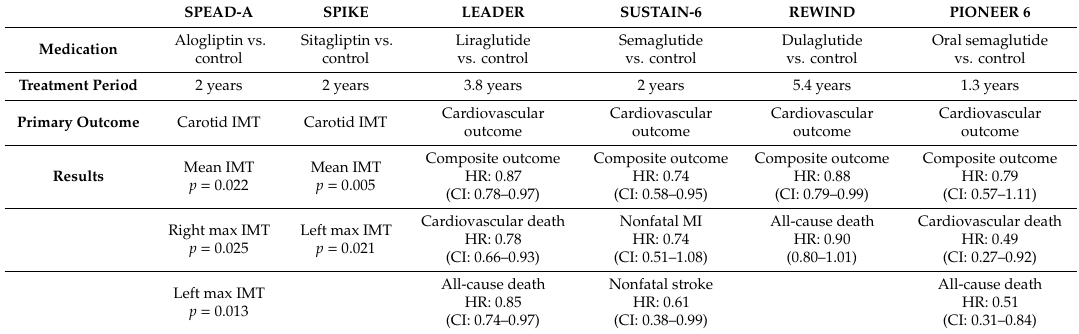
Table 1. Outline observation in various large-scale clinical trials with incretin-based agents. SPEAD-A SPIKE LEADER SUSTAIN-6 REWIND PIONEER 6 Alogliptin vs. Sitagliptin vs. Liraglutide Semaglutide Dulaglutide Oral semaglutide control control vs. control vs. control vs. control vs.